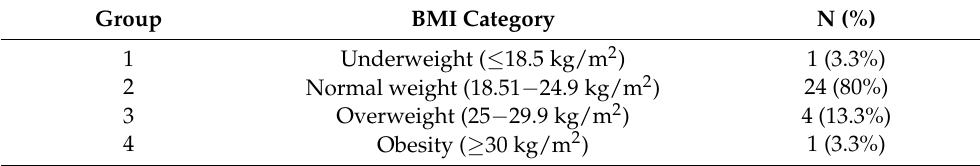
Table 2. Distribution of the sample in four groups based on BMI according to WHO categories.